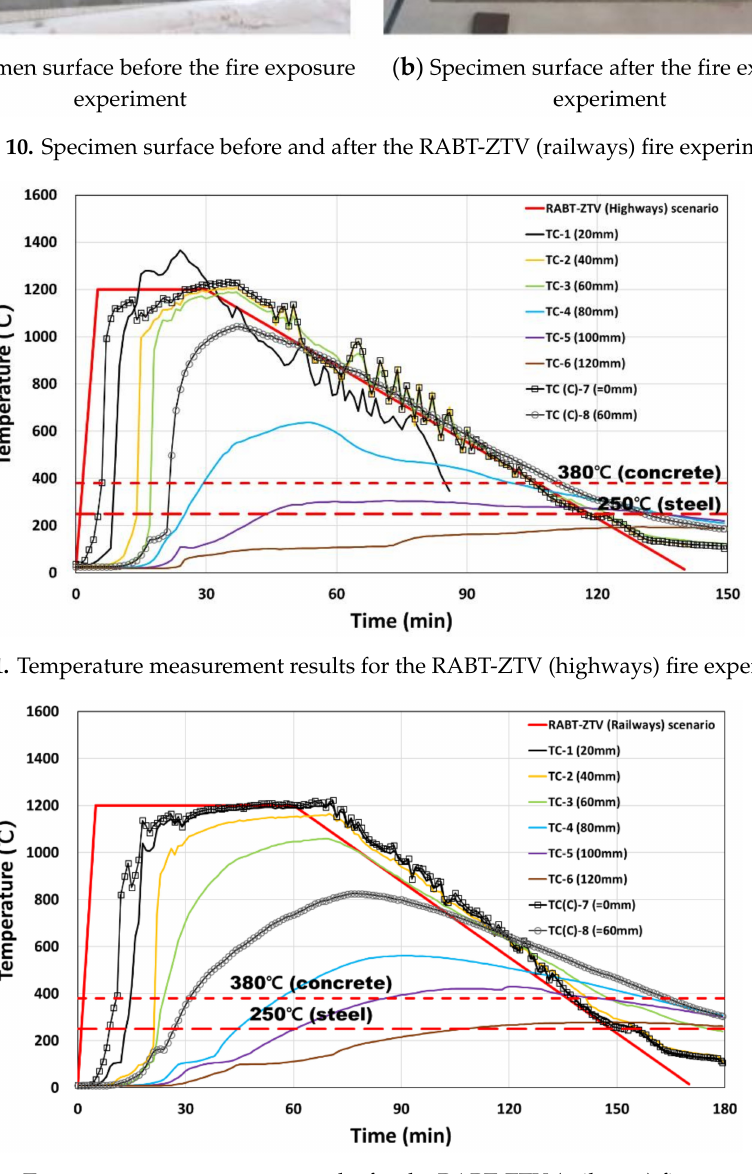
Figure 12. Temperature measurement results for the RABT-ZTV (railways) fire experiment. On the basis of the results of the fire experiments, the appropriate coating thickness of the tunnel structure should be at least 80 mm in order to protect the concrete and internal reinforcement bars from fire. This contradicts the the simulation result that assumed that there had been no spalling in real